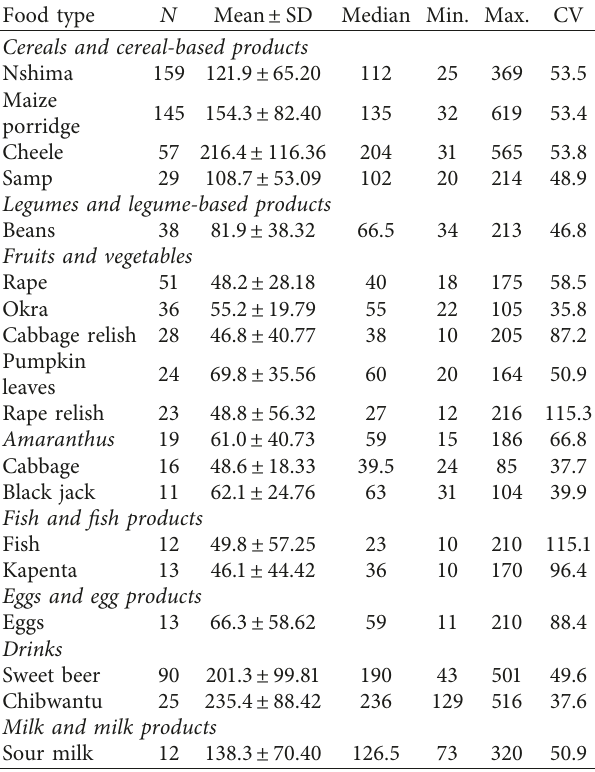
Table 4: Food frequency and weight (grams) consumed by children in